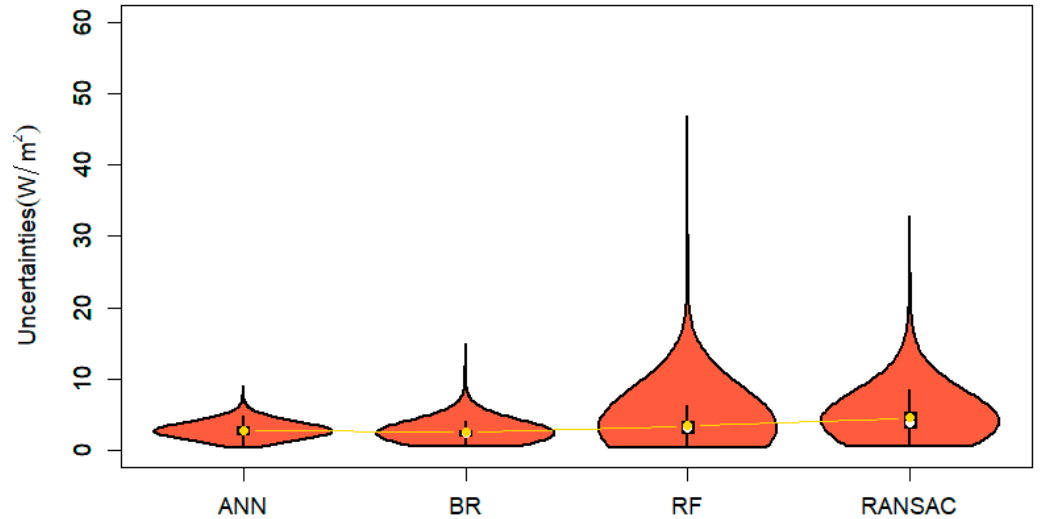
Figure 8. Violin plots of relative uncertainties from four ensemble ocean LHF products over low-latitude area (unit W m − 2 ).